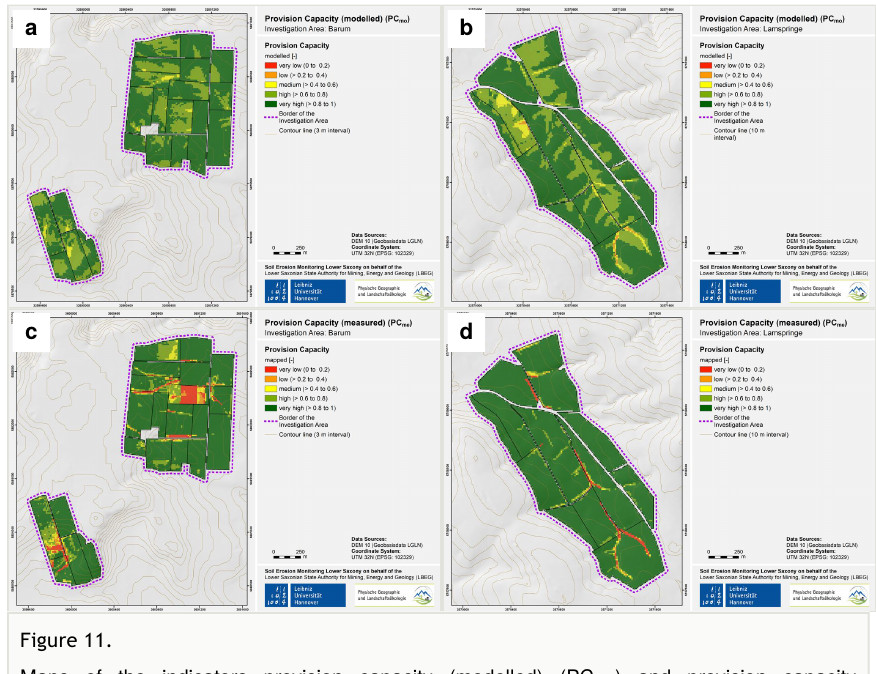
Figure 11. Maps of the indicators provision capacity (modelled) (PC ) and provision capacity (measured) (PC ) for two exemplary investigation areas. a : Provision capacity (modelled) (PC ) in the investigation area Barum (northern region). b : Provision capacity (modelled) (PC ) in the investigation area Lamspringe (southern region). c : Provision capacity (measured) (PC ) in the investigation area Barum (northern region). d : Provision capacity (measured) (PC ) in the investigation area Lamspringe (southern